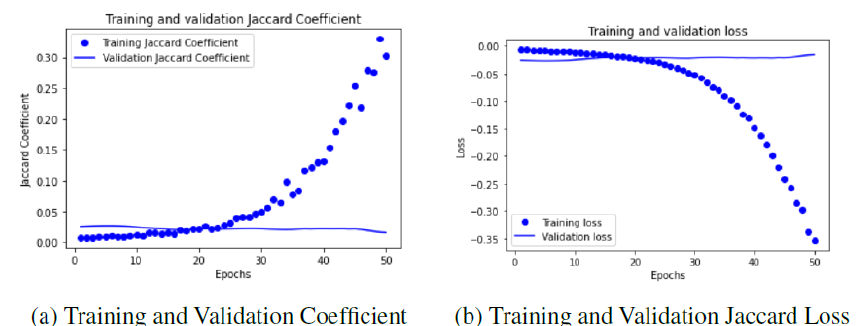
Figure A7. JL segmentation on test data after 300 epochs.